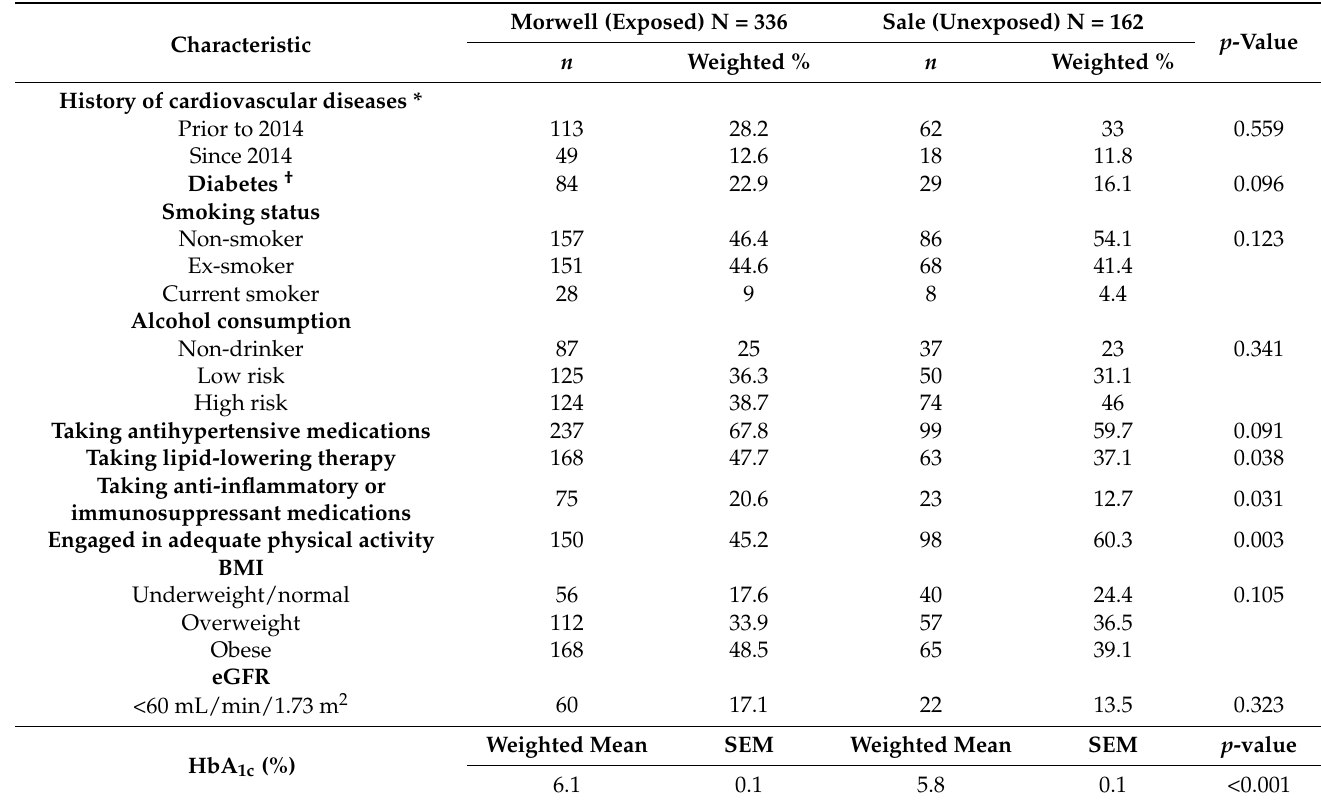
Table 2. Clinical characteristics of participants from Morwell and